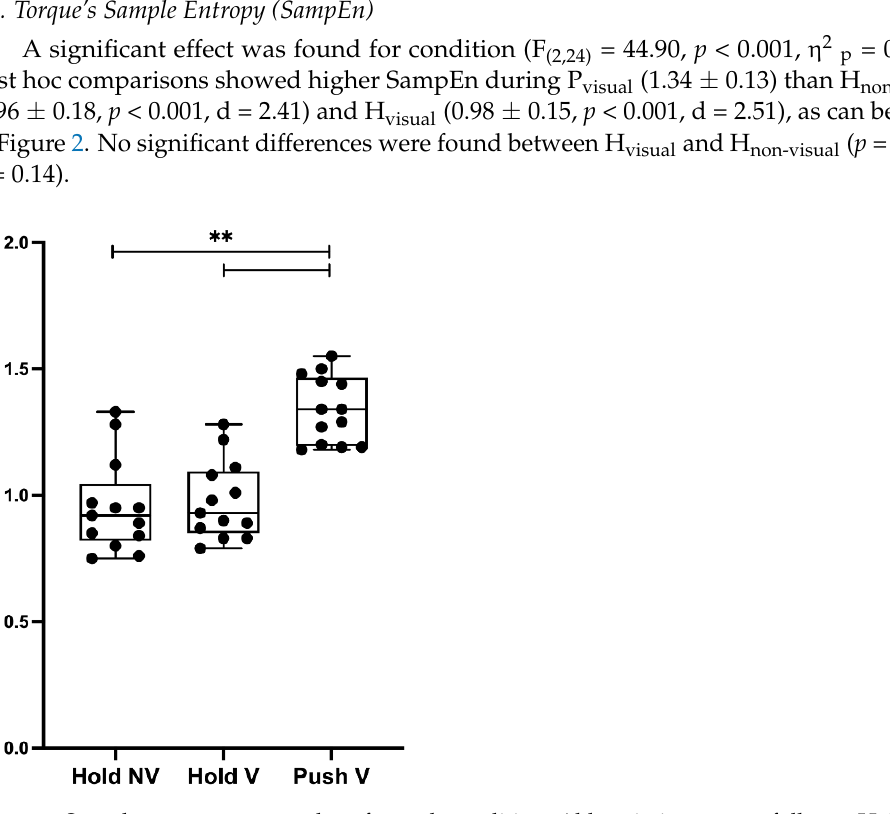
Figure 2. Sample entropy mean values for each condition. Abbreviations are as follows: Hold NV, hold isometric task without visual feedback (H non-visual ); Hold V, hold isometric task with visual feedback (H visual ); Push V, push isometric task with visual feedback (P visual ); ** indicates p < 0.001.